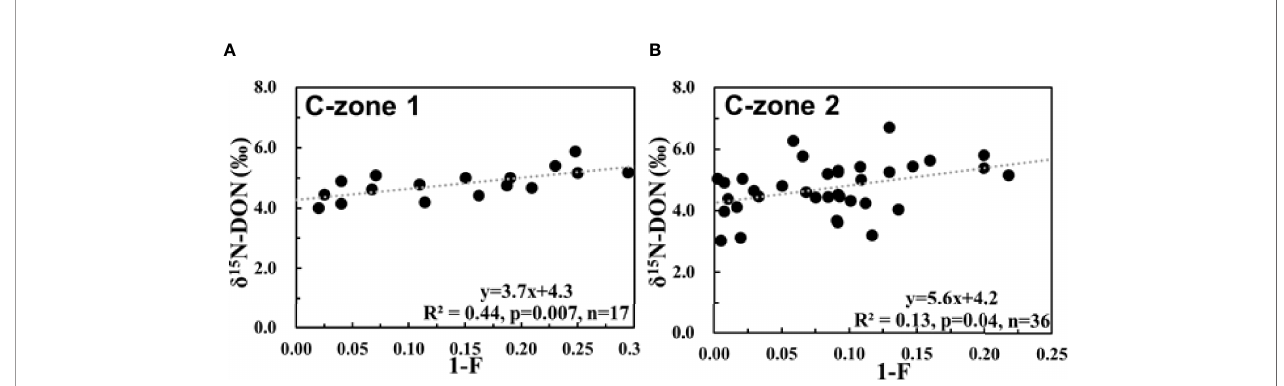
FIGURE 7 | (A) Relationship between d 15 N-dissolved organic nitrogen (DON) and 1-F in C zone 1. (B) Relationship between d 15 N-DON and 1-F in C zone 2. The variable “ F ” is the fraction of the